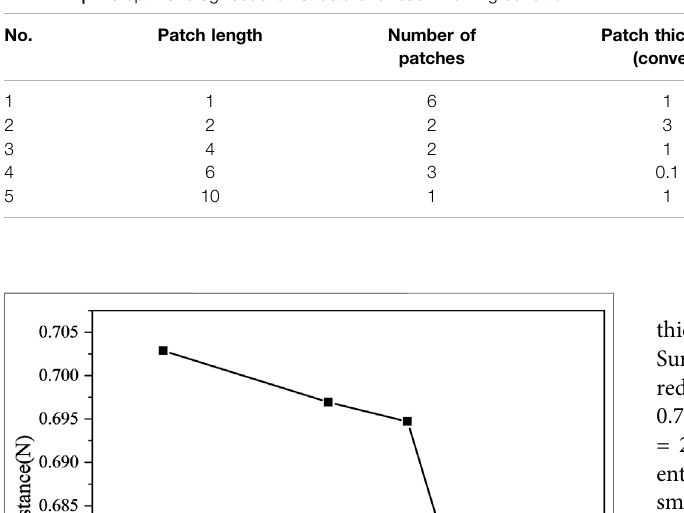
TABLE 4 | The optimal drag reduction structure for each working condition.